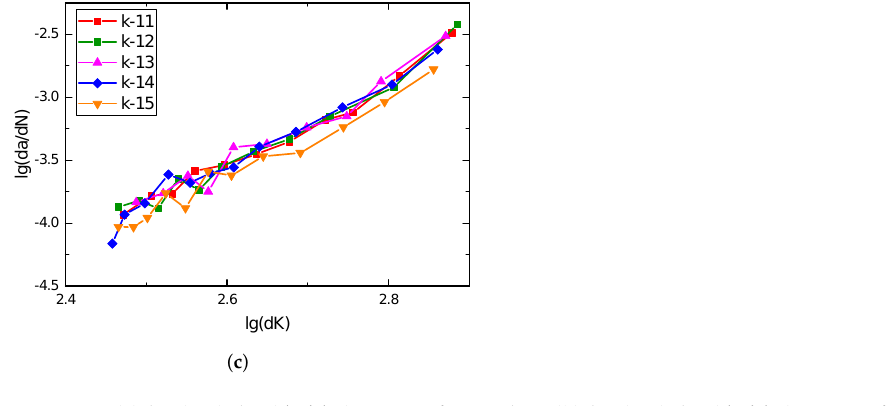
Figure 10. ( a ) log( ∆ K )–log( da / dN ) curve of 15.20 kN. ( b ) log( ∆ K )–log( da / dN ) curve of 18.24 kN. ( c ) log( ∆ K )–log( da / dN ) curve of 19.76 kN. From Equation (8), it can be seen that log( da / dN ) and log( ∆ K ) are linear, so the values of D i and n i of each test piece can be obtained by linear regression analysis. Linear regression analysis was carried out on the all test pieces, and the results are shown in Figure 11. It can be seen from the figures that log( da / dN ) has a strong linear relationship with log( ∆ K ).